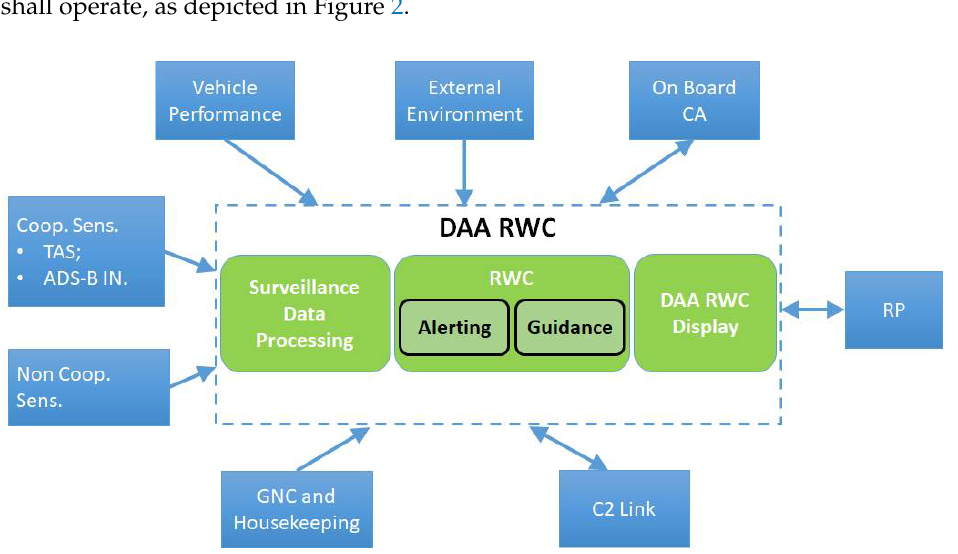
Figure 2. RWC operational context.